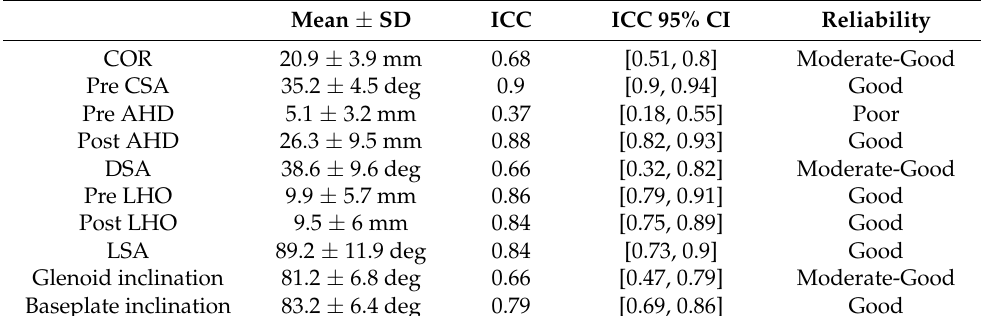
Table 2. Inter-rater reliability for all radiographic measurements and mean values for radiographic